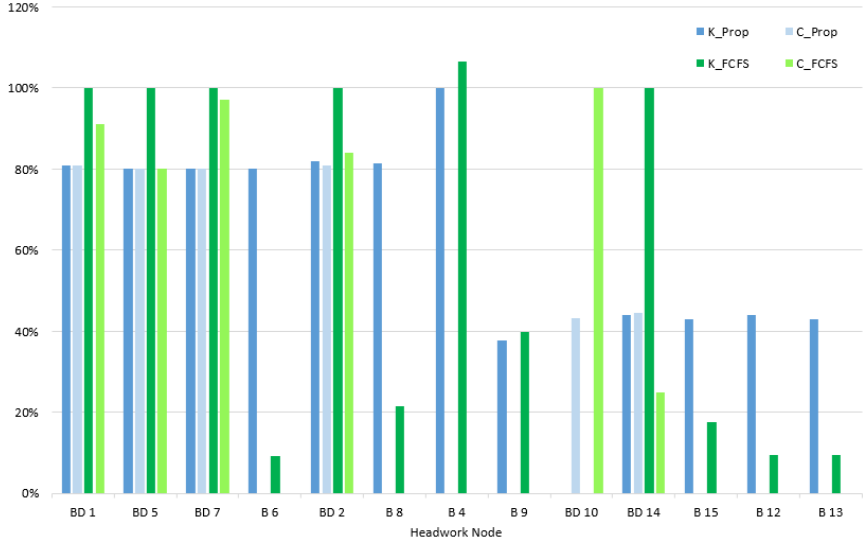
Figure 14. K-factor and C-factor comparison.